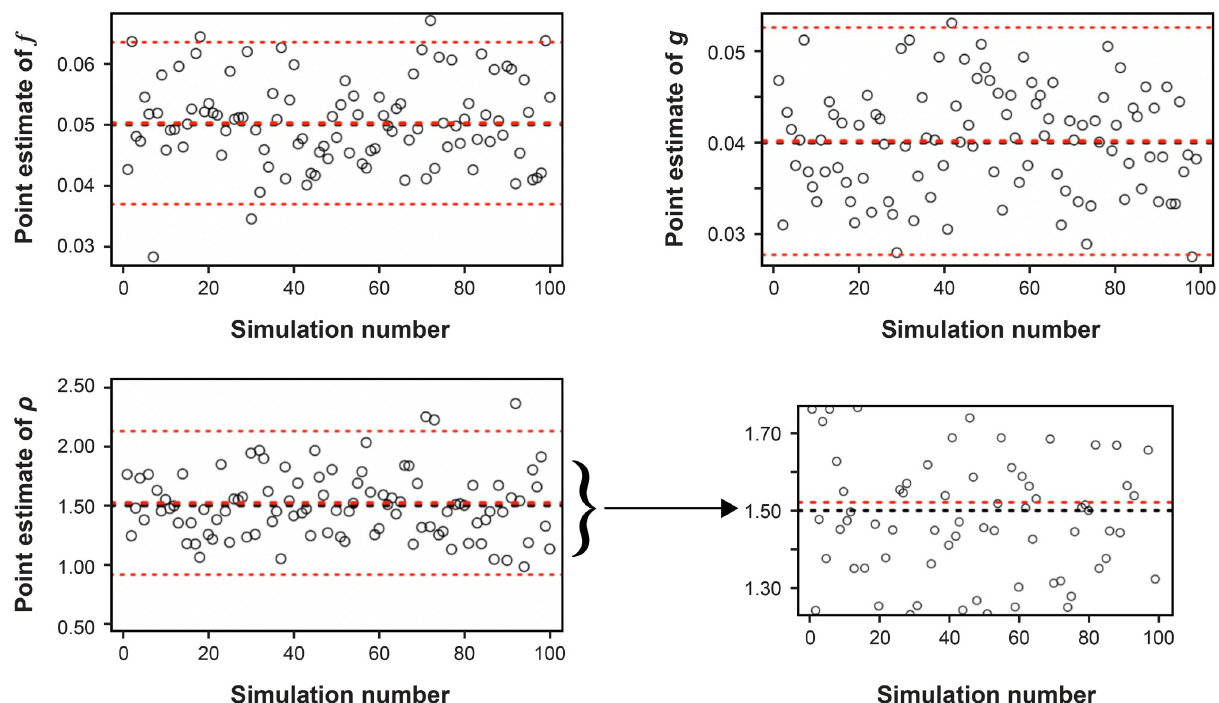
Fig 7. Results of simulating the process of testing. Shown (for ease of presentation) are the first 100 values of the point estimates for f t (upper left panel), g (upper right panel), and ρ (lower left panel). The lower right panel is an expanded version of the point estimates for ρ t t the value of ^ f ; ^ g , or ^ r on the n th replicate of the simulation. The thick red lines represent the averages over the entire 1000 simulations. There are also n n n black lines at the true values of the three parameters. In the lower right panel, the y-axis is expanded to show that the mean of the ^ r text for an explanation. The means of ^ f and ^ g essentially sit on top of the true values; again see the text for an explanation. The thin dotted lines show n n the means of the estimates ± 1.96 times their standard deviations.